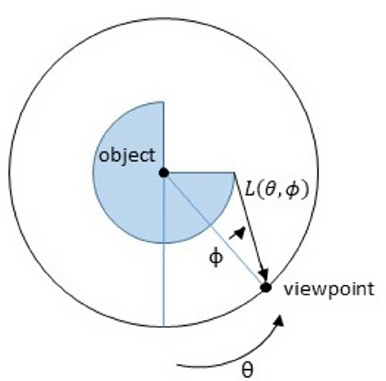
Figure 8. A visual description of the method used to define light field from 2D images in [1,2,4]. The object is conceptually placed within a circle. The angle to the viewpoint around the circle is measured by the angle θ , and the direction that the viewing ray makes with the radius of the circle is denoted φ . For each pair of angles θ and φ , the radiance of light reaching the viewpoint from the object is then denoted by L ( θ ; φ ) , the light field.